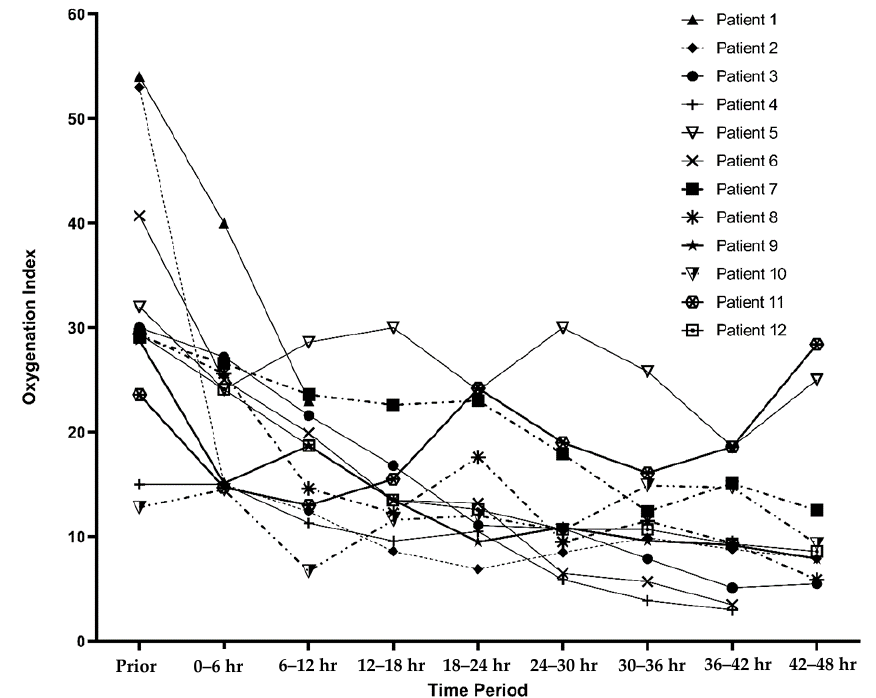
Figure 1. Oxygenation Index trends while proned displayed by individual patient. Figure Legend: Demonstration of oxygenation index trends prior to prone positioning and then at 6 h time epochs up to 48 h. If an oxygenation index was not available, then the oxygenation saturation index was back transformed into oxygenation index as was done by Khemani et al. [19]. Each line represents a di ff erent patient in this case